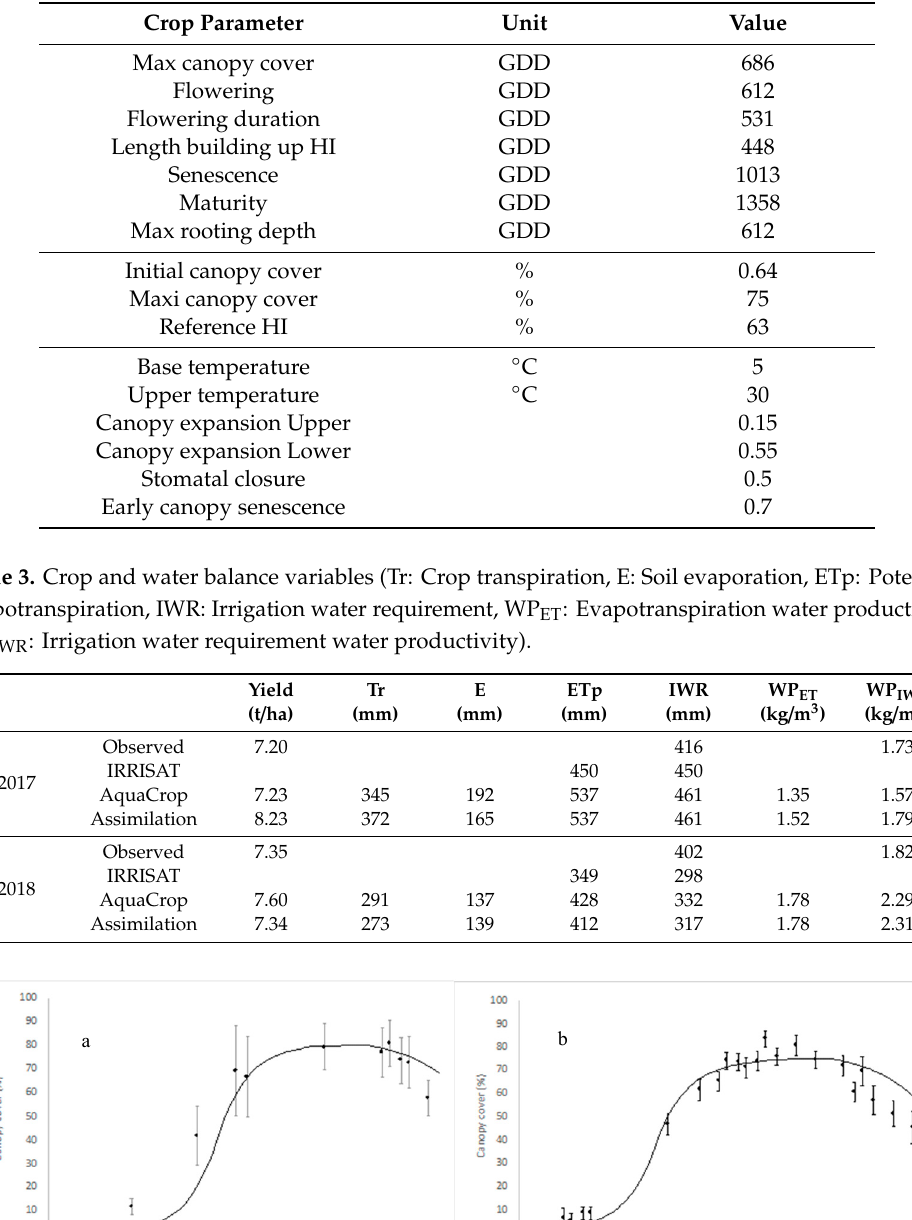
Table 2. Input crop file used for AquaCrop simulations (HI: Harvest index, GDD: Growing degree days).